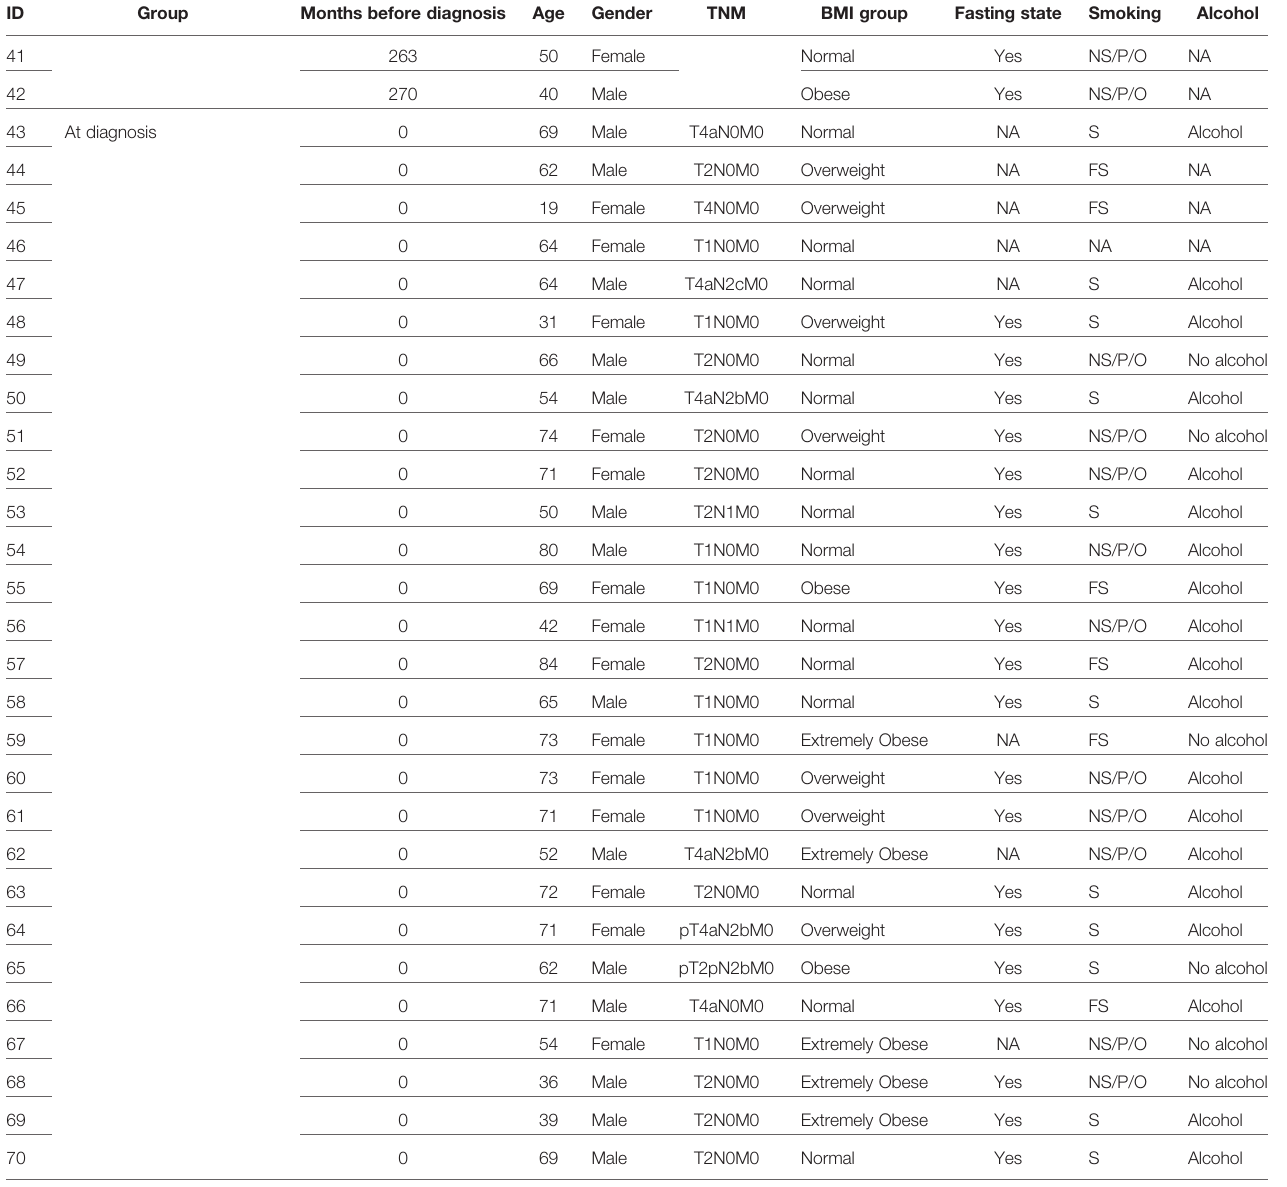
groupings according to TNM stage, T stage, node status or alcohol consumption were found. could contribute to group separation. For pre-diagnostic